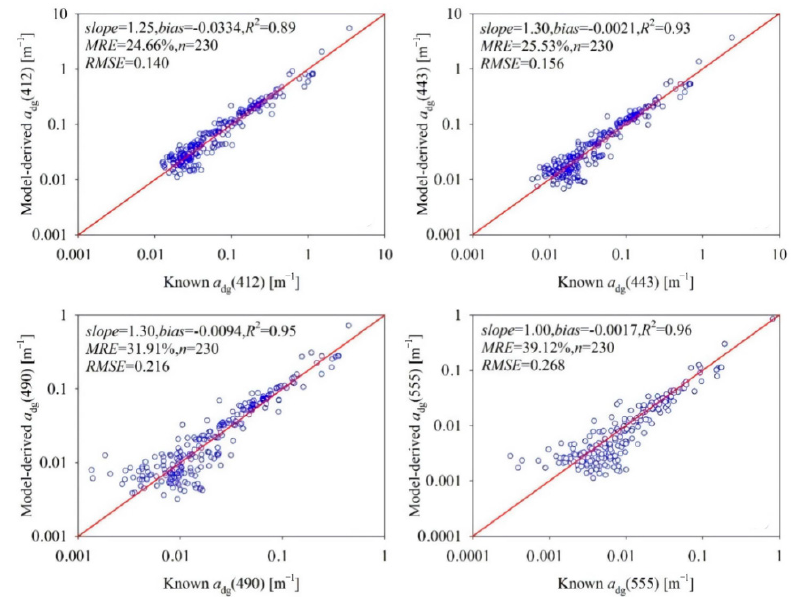
Figure 3. Accuracy evaluation of TAA model a dg ( λ ) retrieval in West Florida Shelf.